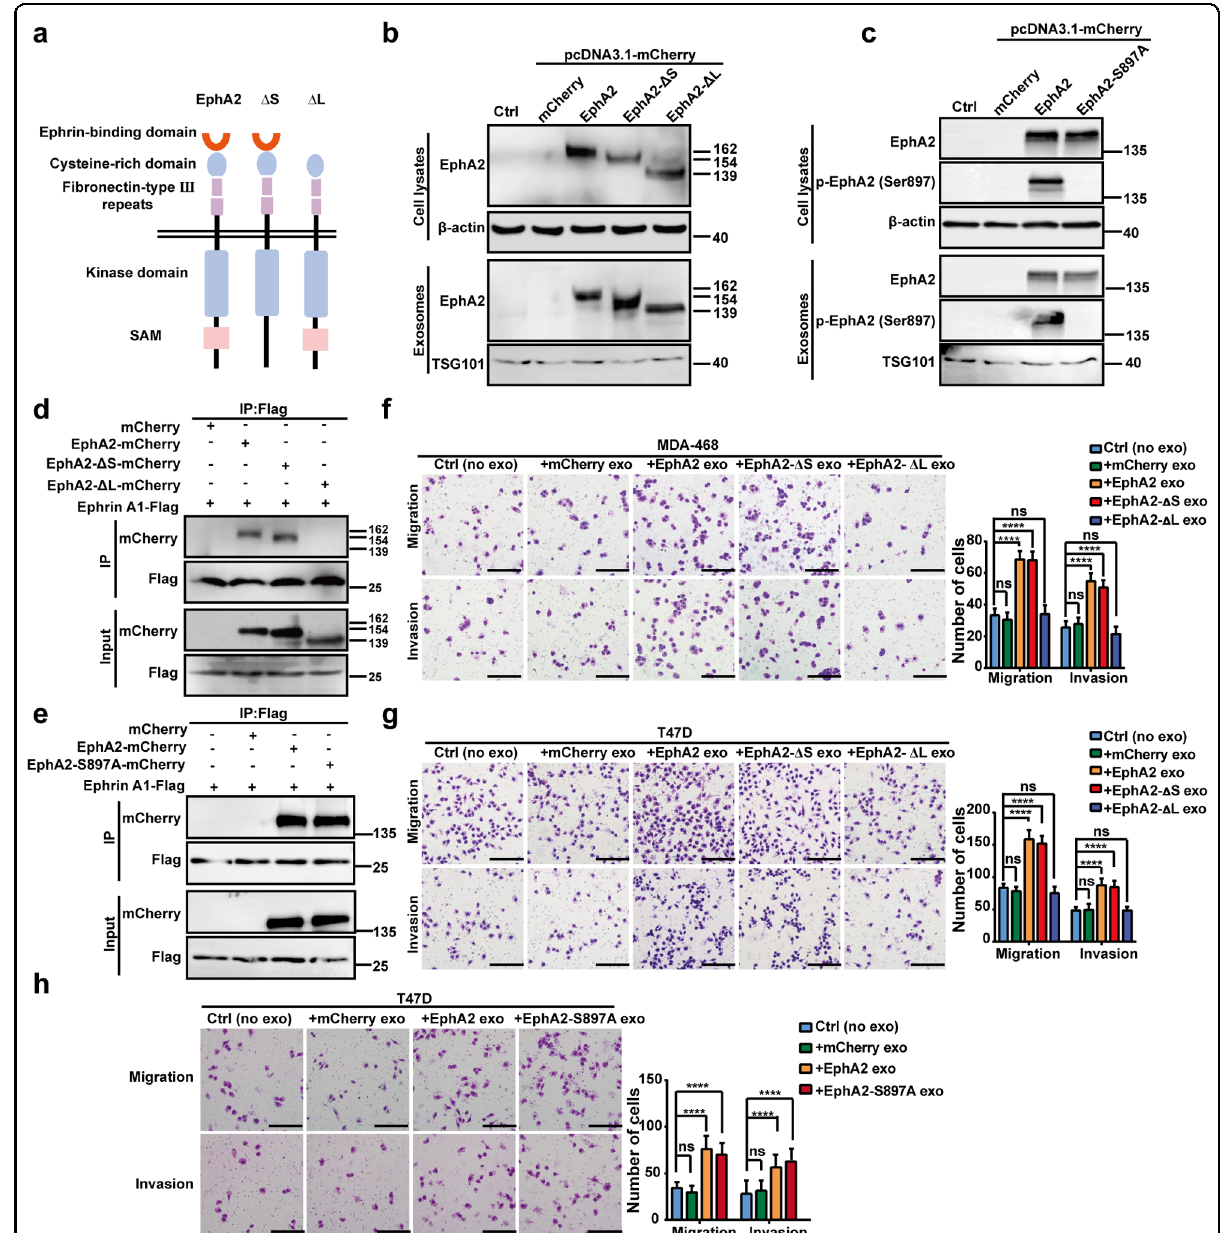
Fig. 4 Exosomal EphA2 promotes migration and invasion of breast cancer cells through the reverse signaling pathway. a Schematic diagram of the structure of EpA2 mutants. The full-length EphA2 and its three mutants, EphA2- Δ L (deletion of the EphA2 ligand-binding domain), EphA2- Δ S (deletion of the EphA2 SAM domain), and EphA2-S897A (Ser897 mutated to alanine) were cloned into the pCDNA3.1-mCherry vector. b The expression of EphA2 and its mutants was detected in cell lysates and exosomes as measured by Western blotting assay. c The expression of EphA2 and EphA2-S897A was detected in cell lysates and exosomes as measured by Western blotting assay. β -actin was used as the loading control. d , e Flag-tagged Ephrin A1 was co-precipitated with mCherry-tagged EphA2, EphA2- Δ S, and EphA2-S897A but not with EphA2- Δ L mutants. f, g Exosomes carrying EphA2 and EphA2- Δ S, not EphA2- Δ L, promoted the migration and invasion abilities of breast cancer cells. All experiments were repeated at least three times. **** P < 0.0001 and ns P > 0.05 indicate no statistical signi fi cance. h Exosomes carrying EphA2-S897A promoted the migration and invasion abilities of breast cancer cells. All experiments were repeated at least three times. **** P < 0.0001 and ns P > 0.05 indicate no statistical signi fi cance. Scale bars: 200 μ